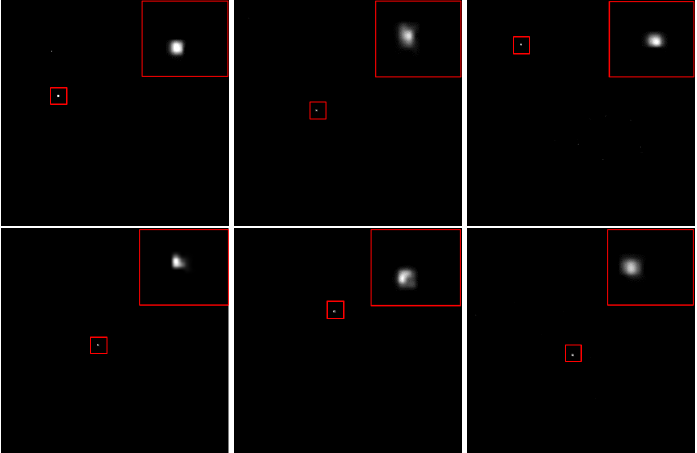
Figure 23. The detection results of the proposed algorithm of Figure